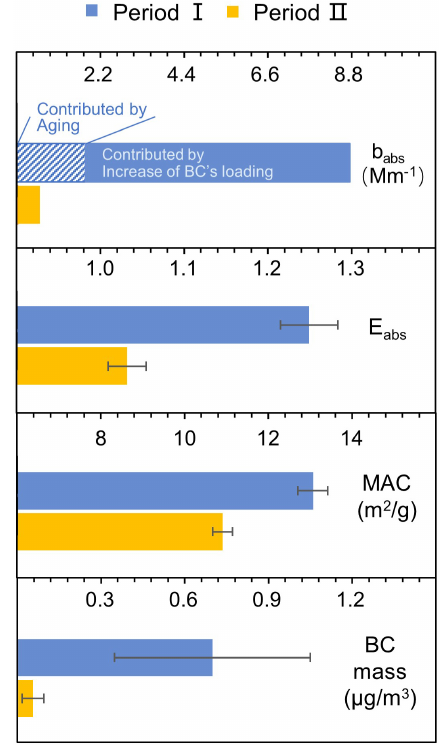
Figure 6. Comparison of BC mass, mass absorption cross-section, absorption enhancement, and absorption coefficient in Period I and II (at the wavelength of